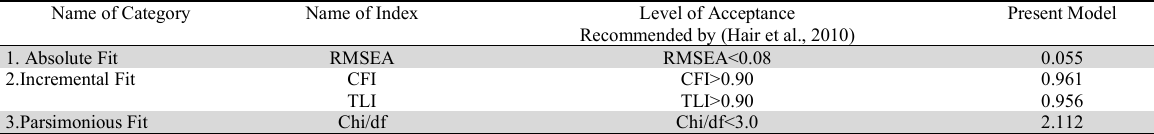
The Goodness of Fit Index of the Model Name of